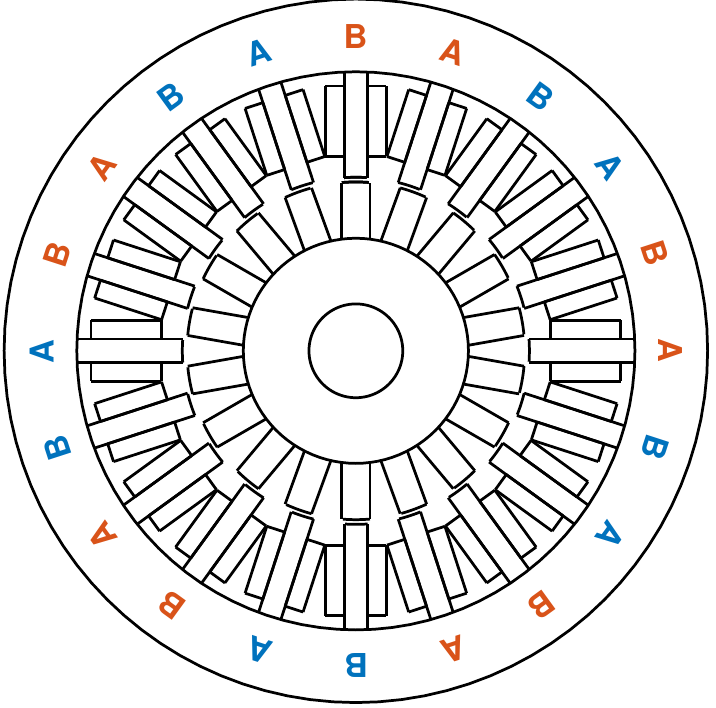
Figure 1. Schematic of a bipolar stepper motor. Letters A and B denote separate electrical coils. The coil letter color denotes the winding direction of the stator pole (either clockwise or